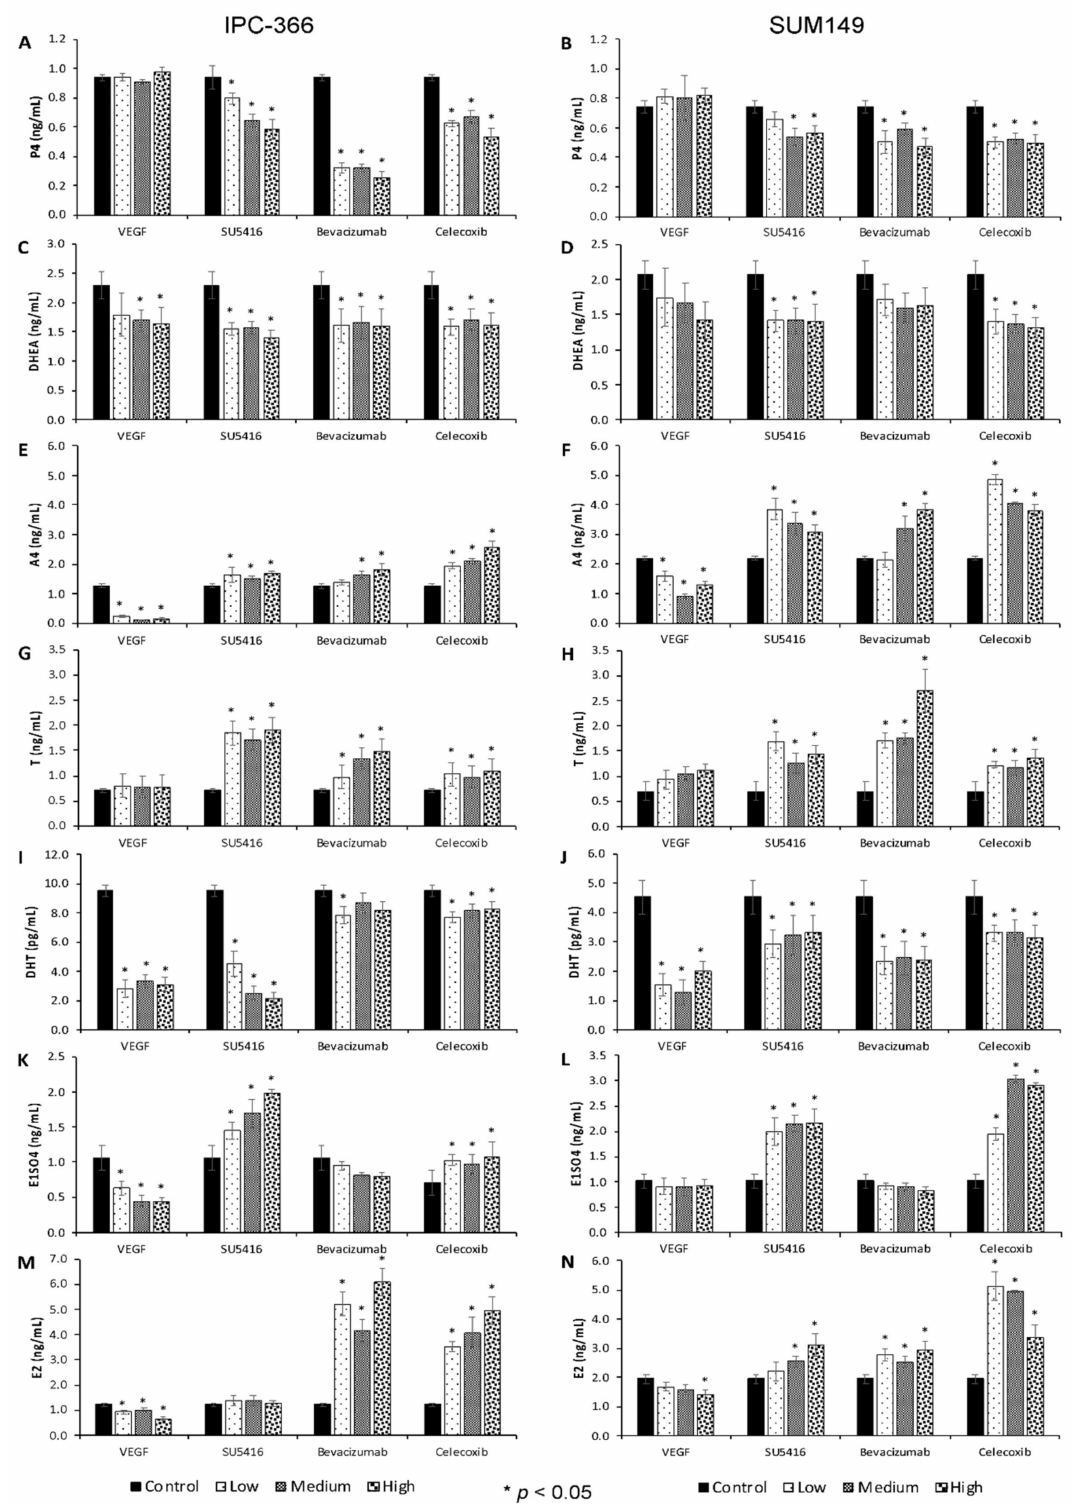
Figure 2. Sex steroid hormone concentrations in culture media of control and treated IPC-366 and SUM-149 cells at 72 h after the addition of low, medium, and high concentrations of VEGF (0.62 uM, 1.25 uM and 2.5 uM); SU5416, bevacizumab and celecoxib (1.5 uM, 3 uM and 6 uM). ( A , B ) Progesterone (P4). ( C , D ) Dehydroepiandrosterone (DHEA). ( E , F ) Androstenedione (A4). ( G , H ) Testosterone (T). ( I , J ) Dihydrotestosterone (DHT). ( K , L ) Estrone sulphate (E1SO4). ( M , N ) Estradiol (E2). Bar represents means ± SEM. * Significant differences between control and treatment groups ( p <